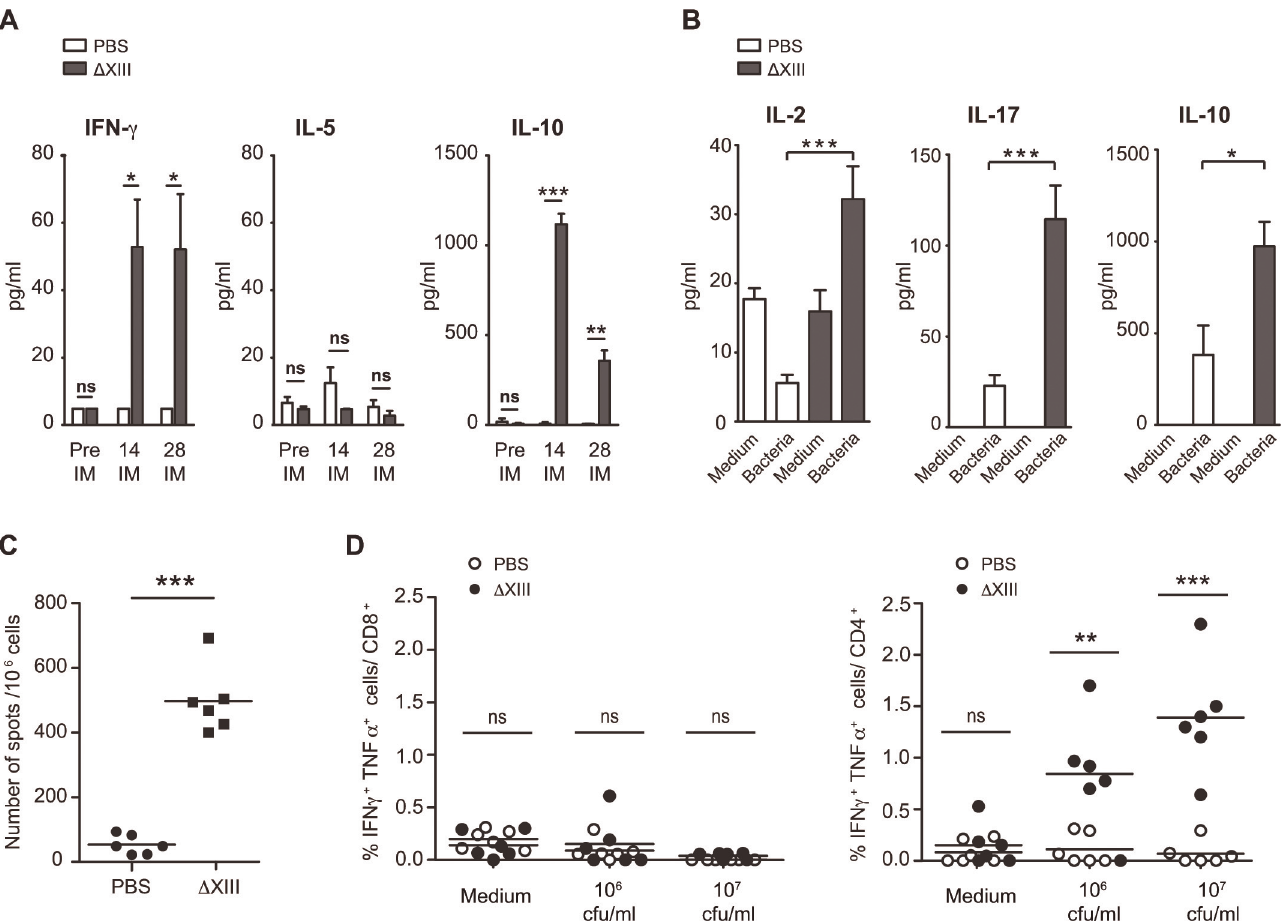
Fig 5. Δ XIII induced cellular immune responses. A) Sera from Δ XIII immunized mice present significantly higher levels of interferon gamma (IFN- γ ) and IL-10 than sera from the control group, treated with PBS. Quantification (pg/ml) of IFN- γ , IL-5 and IL-10 in pooled sera from the control group (PBS) and from the Δ XIII immunized group was carried out using respective ELISA kits. Error bars represent standard deviation between duplicate wells. Statistical analysis was carried out using a two-way analysis of variance combined with the Bonferroni test. ns = no significant difference; * P < 0.05; ** P < 0.01; *** P < 0.001. B) Δ XIII immunization induces production of cytokines in splenocytes. 28 days postimmunization, splenocytes were harvested from control and Δ XIII immunized mice and restimulated for 48 h with 10 7 cfu of heat-killed Δ XIII bacteria. RPMI media was used as a non-stimulating control. Cell supernatants were harvested and analyzed for IL-2, IL-10 and IL-17 production using respective ELISA kits. Statistical analysis was carried out using the unpaired Student t test. C) Numbers of IFN- γ producing cells in spleens from control and Δ XIII immunized mice were determined by ELISPOT assay. Splenocytes were harvested from all mice at 28 days after immunization. The results are expressed as spots per million splenocytes minus background from cells stimulated with 10 7 cfu of heat-killed Δ XIII bacteria. Each point represents an individual mouse. Lines indicate the mean of the replicates. Significant differences between groups are indicated and were determined using the unpaired Student t test. *** P < 0.001. D) CD4+ T cells produce IFN- γ and TNF- α upon ex vivo re-stimulation following vaccination with Δ XIII. 28 days after immunization, splenocytes from control and Δ XIII immunized mice were plated and stimulated for 6 hours with medium, 10 6 or 10 7 cfu of heat-killed Δ XIII bacteria. Cells were surface stained with anti-CD4 and anti-CD8 mAbs and intracellularly stained with anti-IFN- γ and anti-TNF- α antibodies. Shown are percentages of IFN- γ and TNF- α cells out of total CD4+ and CD8+ T cells. Each point represents an individual mouse. Lines indicate the mean of the replicates. Significant differences between control and vaccinated groups are indicated and were determined using the unpaired